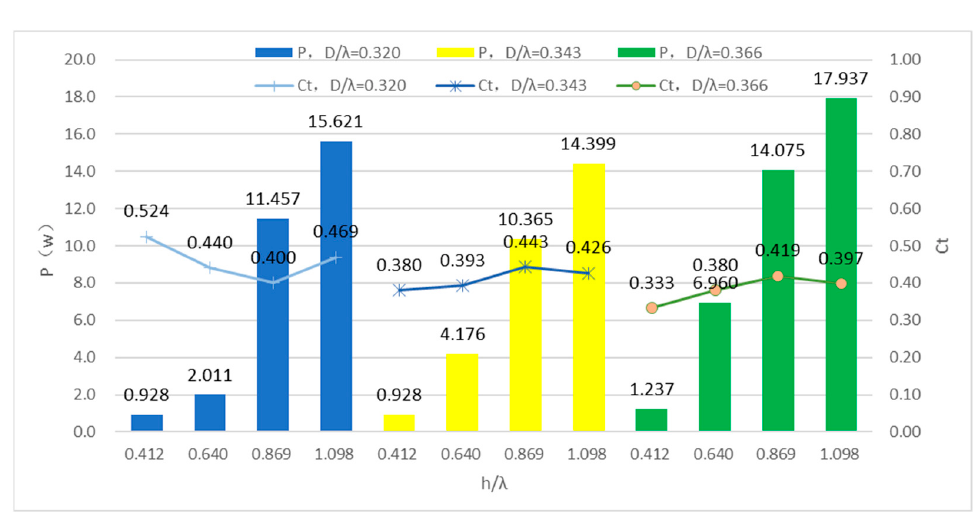
Figure 9. Numerical simulation data plot. Figure 9. Simulation experiment data graph with h/ λ as variable.